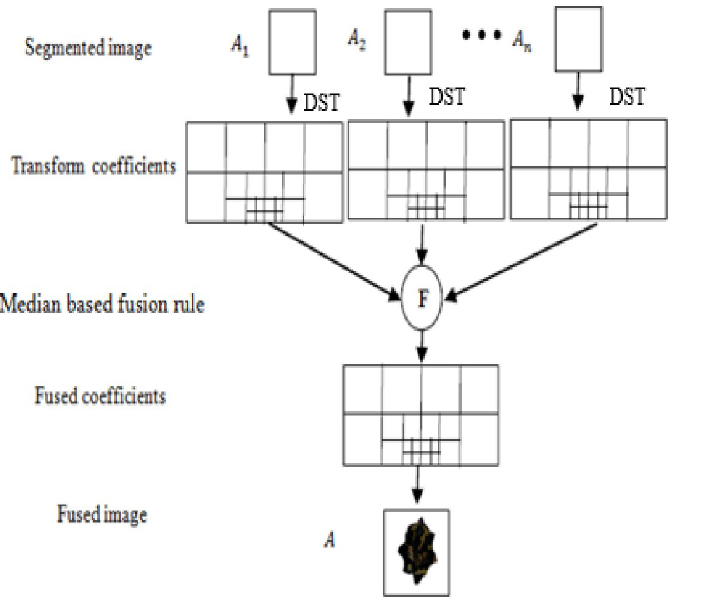
Fig 3. Image fusion based on discrete Shearlet transform.